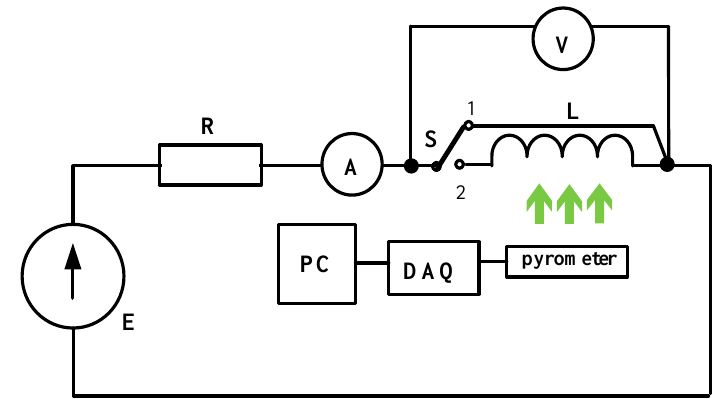
Figure 2. Set-up to measure thermal parameters of the inductor.